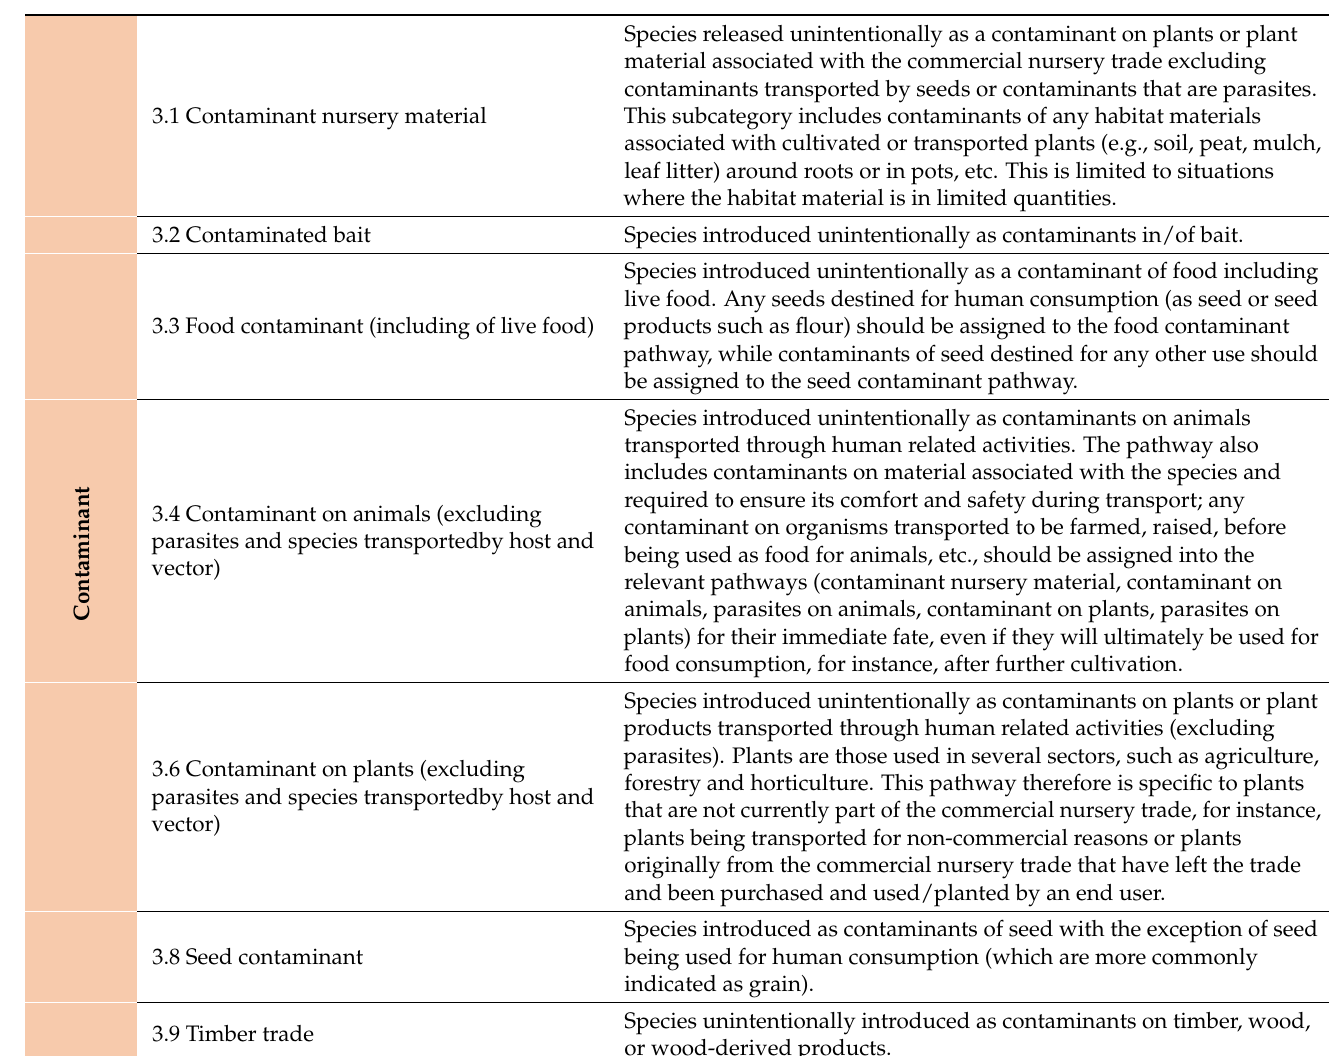
Table 2. Accidental pathways sub-categories, in the transport category, related to agriculture accord- ing to the classification of the Convention on Biological Diversity (CBD, 2014), as interpreted by the IUCN